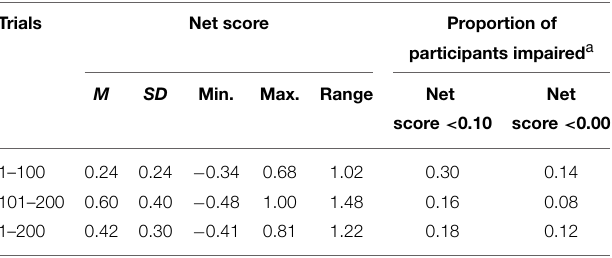
TABLE 2 | Mean net scores (expressed as proportions of number of trials) in the present study, variability statistics, and proportions of participants satisfying criteria for impaired